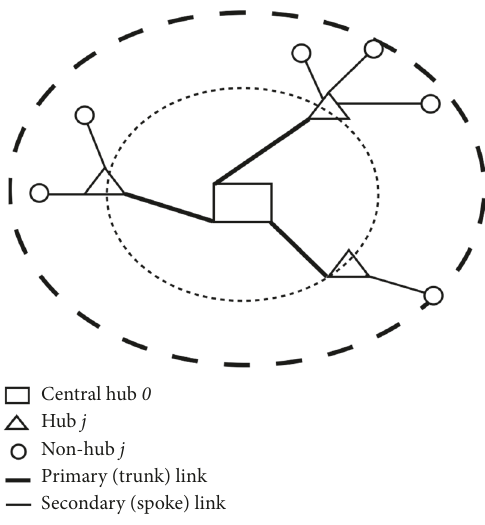
Figure 1: Airline star-star